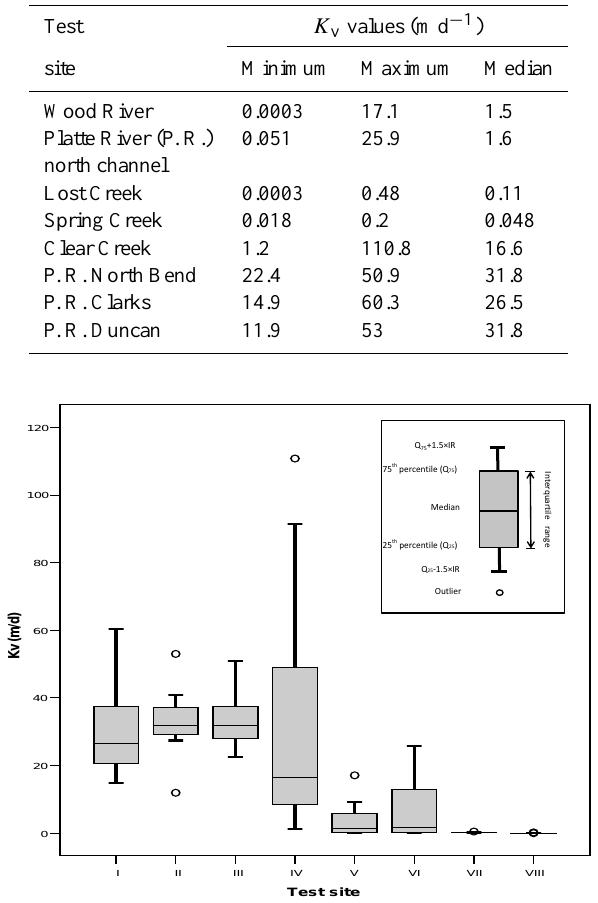
Fig. 2. Box plot to show the K v distribution for the eight test sites. The label on the horizontal axis is designated as follows: I=Platte River-Clarks, II=Platte River-Duncan, III=Platte River- North Bend, IV=Clear Creek; V=Wood River, VI=Platte River north channel, VII=Lost Creek, VIII=Spring